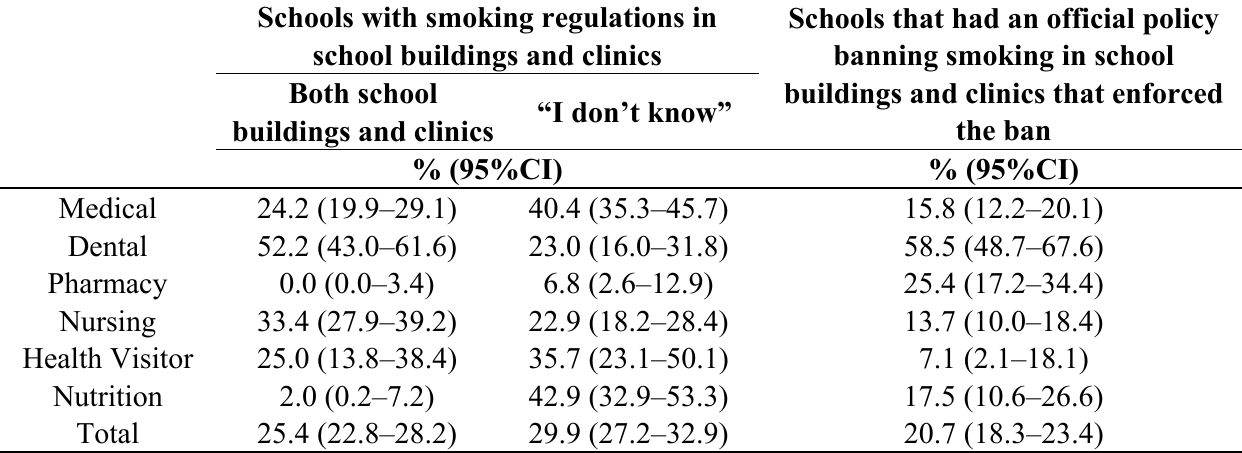
Table 4. Smoking regulations among Third-Year Health Professional Students.